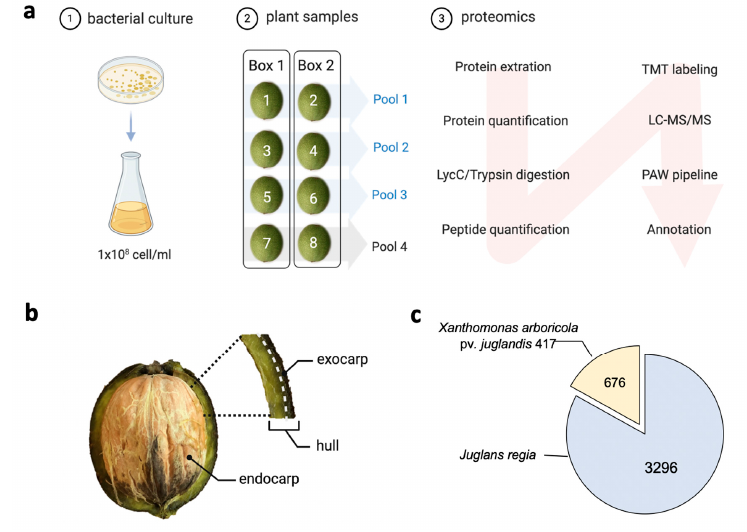
Figure 2. Overview of sample processing. ( a ) Sample preparation and proteomics workflow: (1) inoculations were started by plating Xaj cells in YEP plates and cultivating overnight. Cells were transferred to YEP liquid media and cultured to reach 1 × 10 8 cells/mL after wash and resuspension in MgCl 2 . (2) The experimental design of nut inoculations and pool formations used for proteomics (Pools 1 to 3) and scanning electron microscopy (Pool 4). (3) The proteomics pipeline used for three pools of each sample type. ( b ) Depiction of the hull material used for microscopy and proteomics. ( c ) Total proteins identified for Jr and Xaj. TMT: tandem mass tag and PAW: proteomic analysis workflow. Created with BioRender.com. Int. J. Mol. Sci. 2020 , 21 , x FOR PEER REVIEW